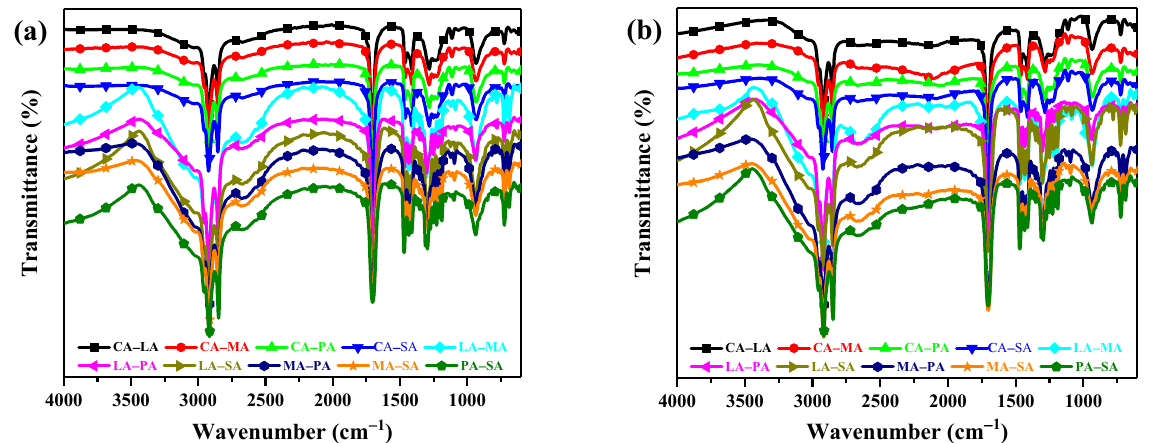
Figure 7. FT–IR spectra of ten fatty acid binary eutectic mixtures before and after 1000 thermal cycling ( a ) before thermal cycling, ( b ) after thermal cycling.